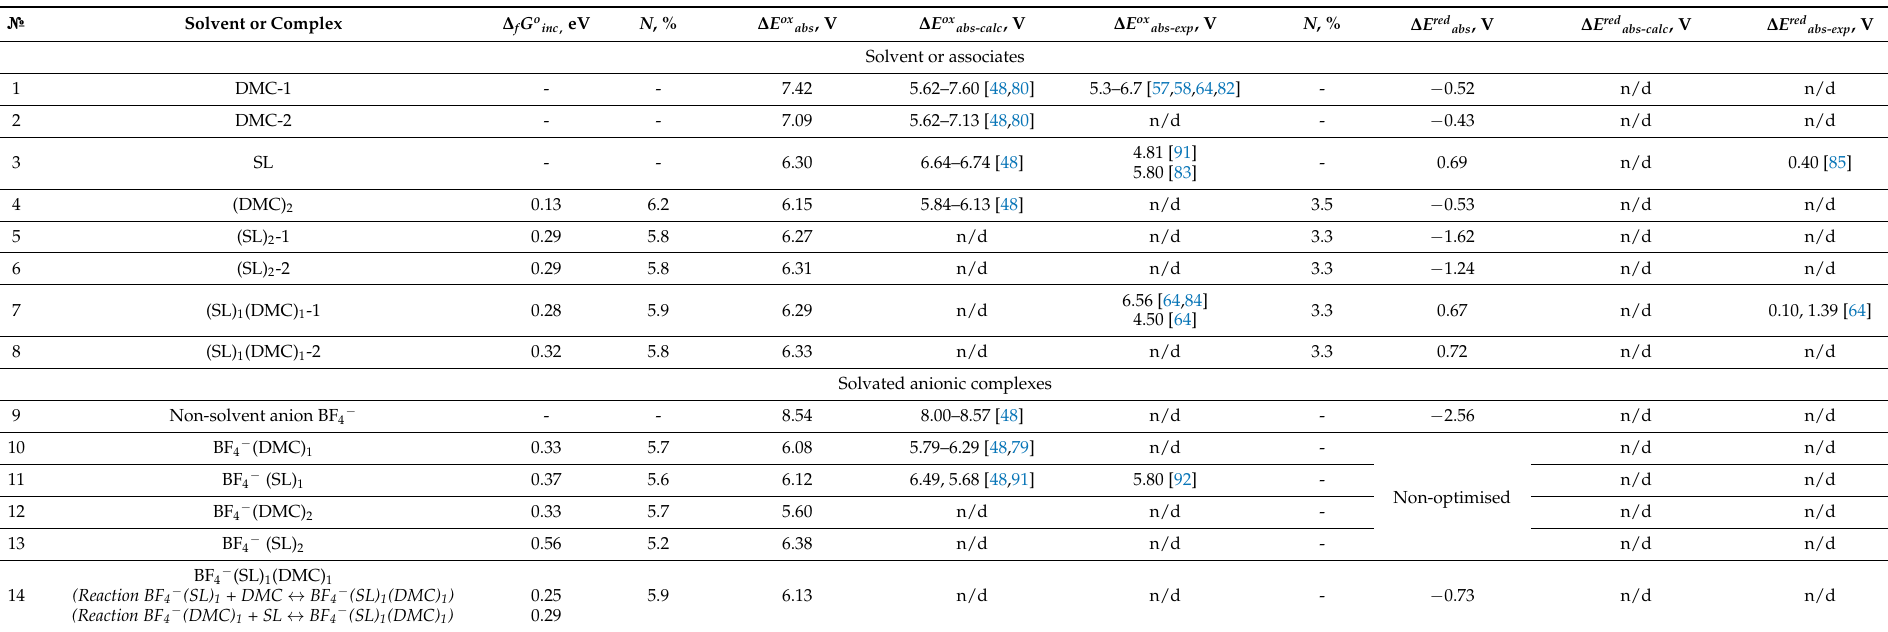
Table A2. Thermodynamic and oxidative parameters of solvent molecules and various complexes existing in the system 1 m LiBF 4 SL/DMC: ∆ f G o inc —incremental (stepped) Gibbs energy of formation (eV); N —Maxwell–Boltzmann energy distribution; ∆ E ox abs —adiabatic oxidation potential estimated in this work (M052X/TZVP); ∆ E ox abs-calc —adiabatic oxidation potential, published earlier, estimated on the basis of quantum chemical calculations; the oxidation potential; ∆ E red abs —adiabatic reduction potential estimated in this work (M052X/TZVP); ∆ E red abs-calc —adiabatic reduction potential published earlier, which was estimated on the basis of quantum chemical calculations; ∆ E red abs-exp —experimentally measured value of the reduction